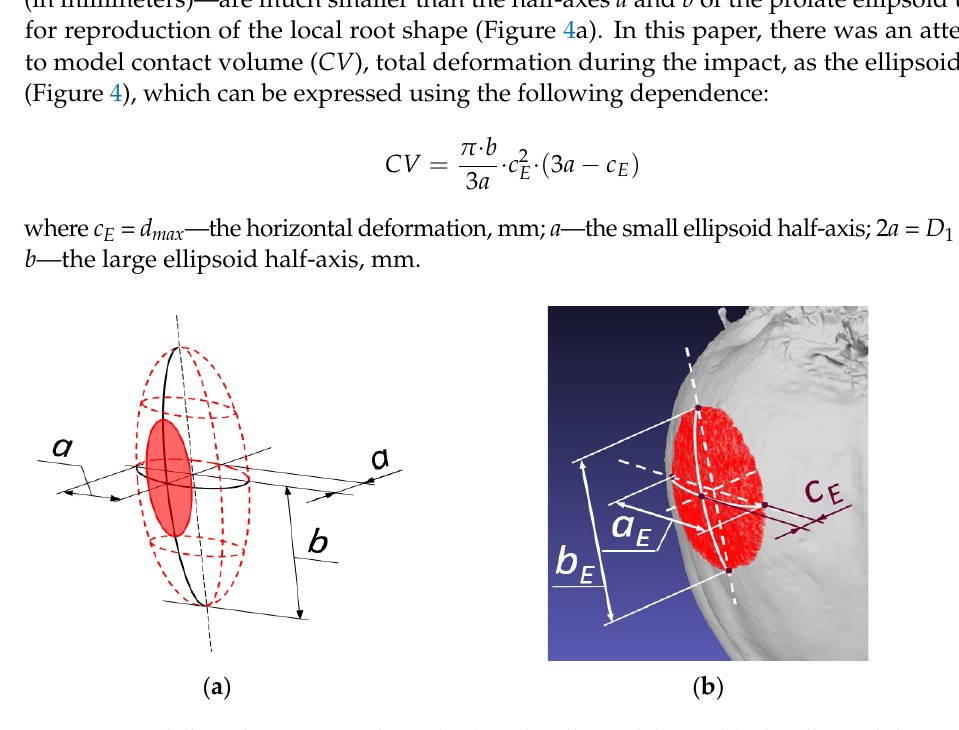
Figure 4. Modelling the contact volume ( CV ) as the ellipsoidal cap. ( a ) The ellipsoid dimensions; ( b ) the ellipsoid cross-section dimensions: a E , b E , d max = c E